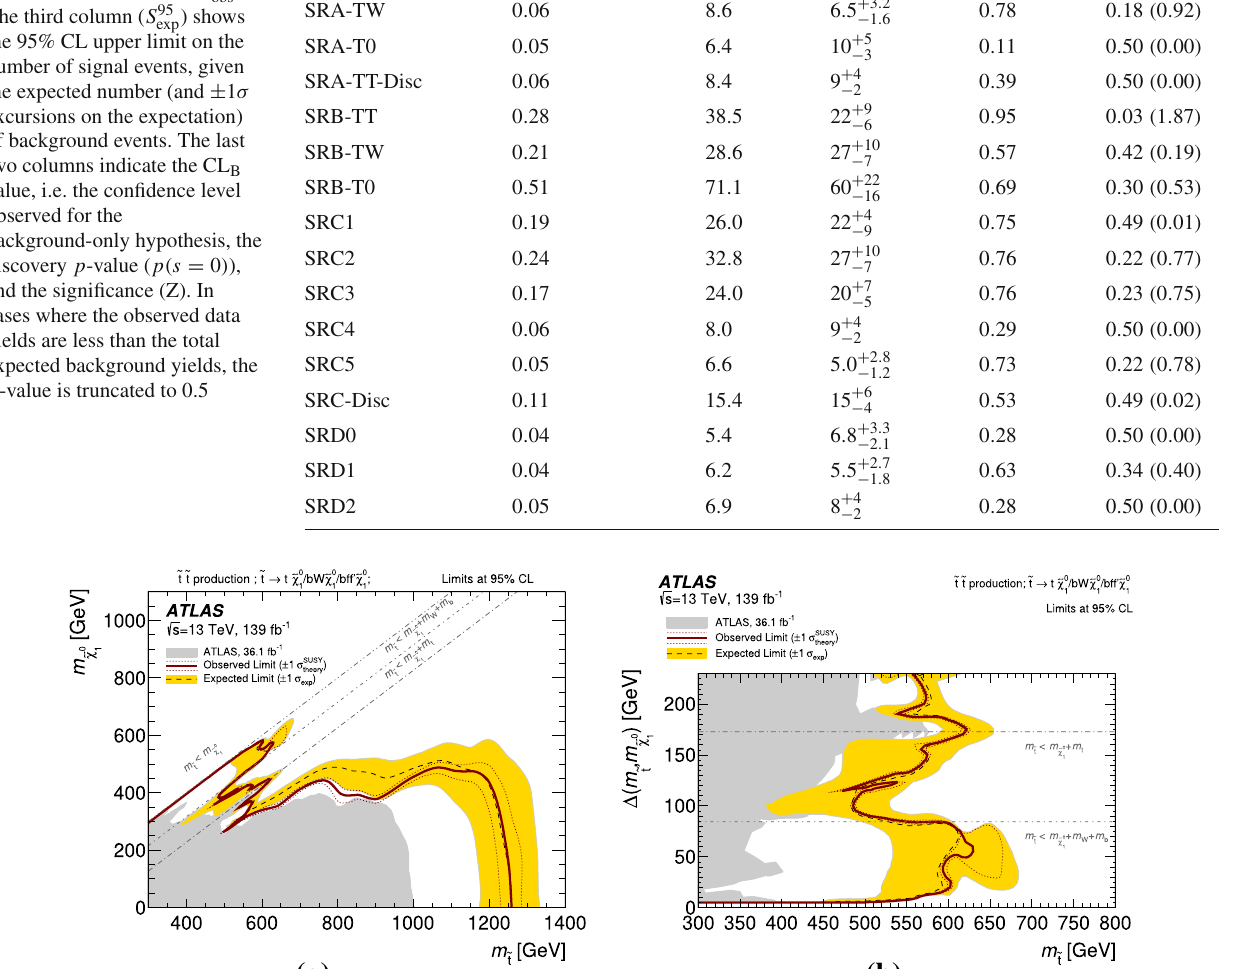
Table 14 Left to right: 95% CL upper limits on the visible cross section ( (cid:8) (cid:15)σ (cid:9) 95 ) and on the obs ). number of signal events ( S 95 obs